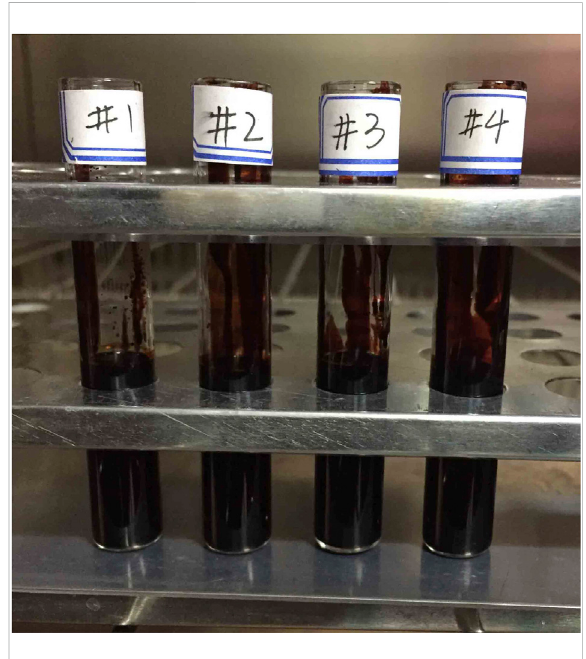
FIGURE 7 Kerosene-based magnetic fl uid evaporation control